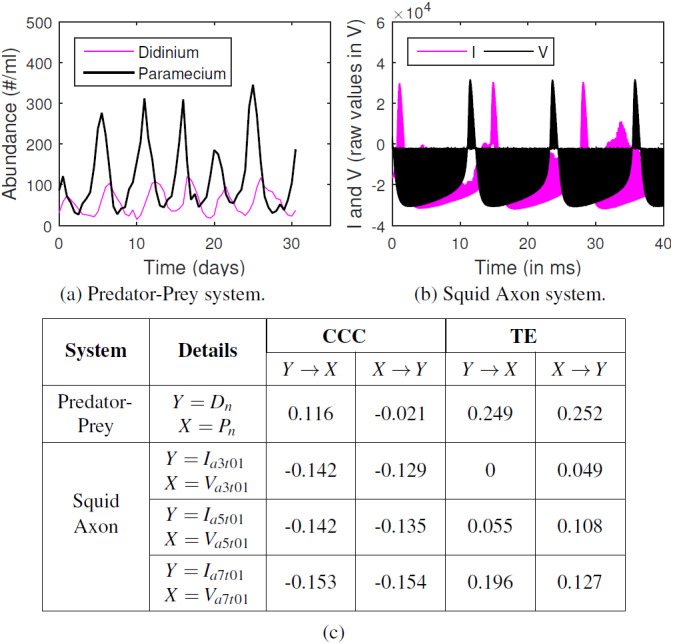
CCC, TE on real-world time series. (A) Time series showing population of Didinium nasutum (Dn) and Paramecium aurelia (Pn) as reported in Veilleux (1976), (B) Stimulus current (I) and voltage measurements (V) as recorded from a Squid Giant Axon (‘a3t01’) in Paydarfar, Forger & Clay (2006). (C): Table showing CCC and TE values as estimated for systems (A) and (B).